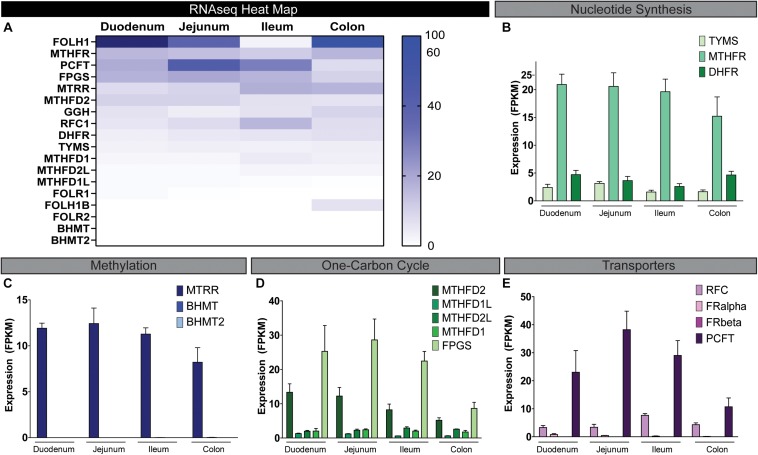
RNAseq expression of folate-associated genes in human enteroids. Enteroids derived from diverse intestinal segments were examined by RNAseq. (A) Heat map of the expression of folate-associated genes in duplicate biological samples from human duodenum, jejunum, ileum, and colon enteroids. Expression is indicated from high (dark blue) to low (white). The data were divided into four groups based on gene expression: nucleotide synthesis (B), methylation (C), one-carbon cycle (D), and folate transporters (E) (n = 2 biological replicates).